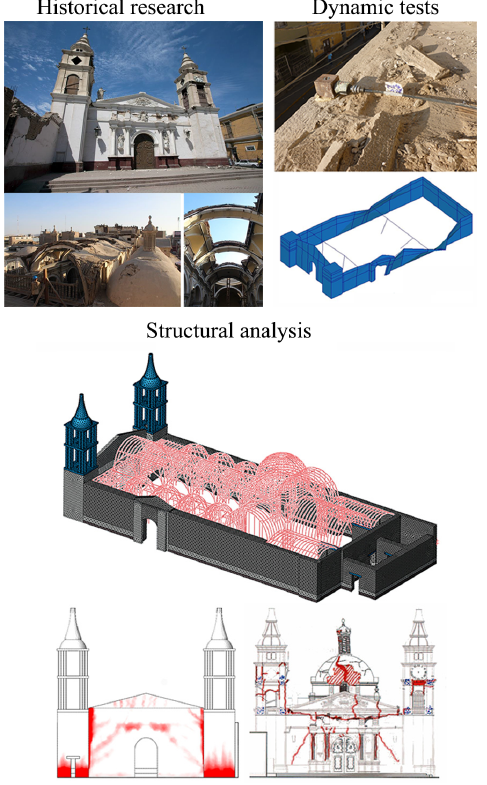
Figure 7. Conservation of cultural heritage buildings, methodology and application to case studies: Cathedral of Ica in Peru [14].